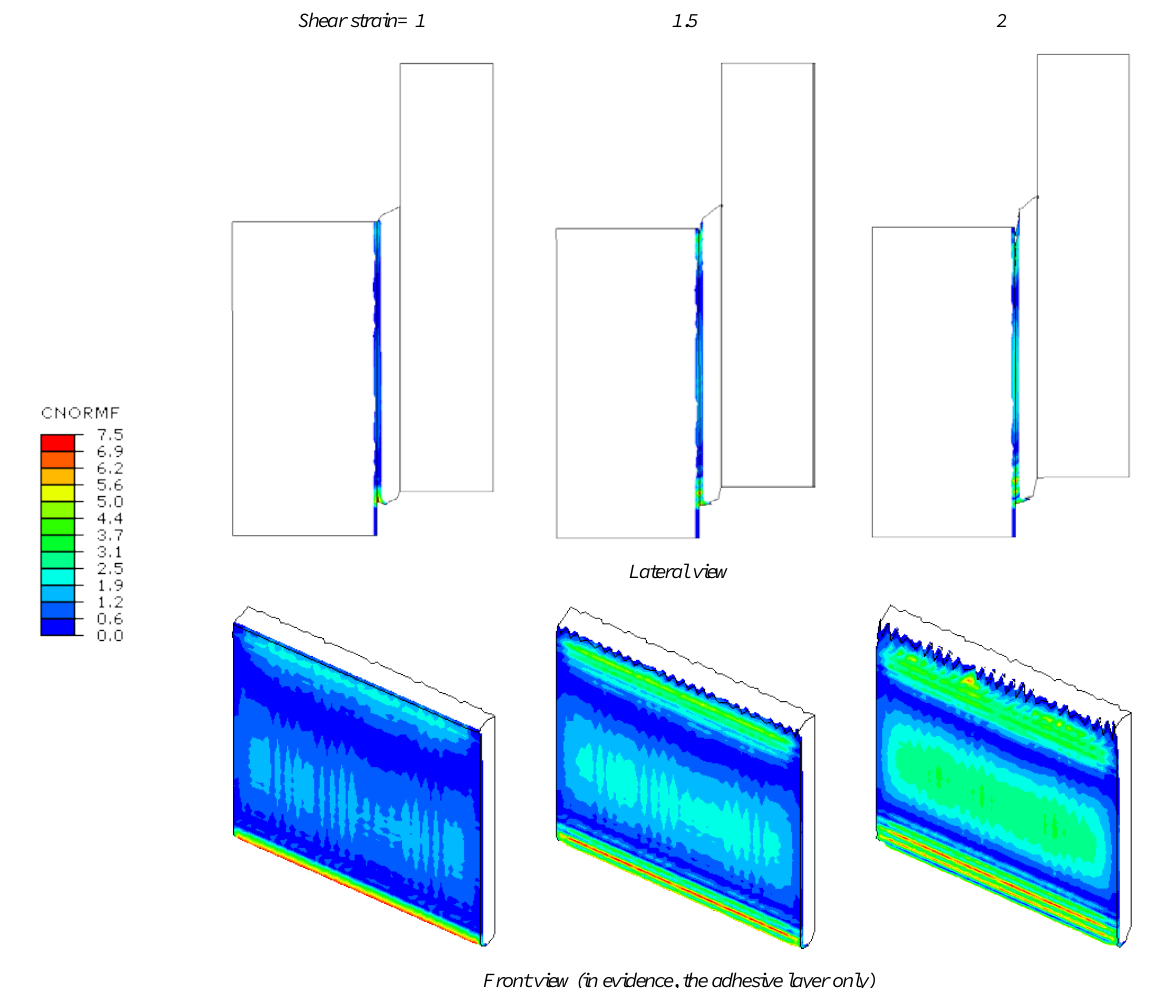
Fig. 9 Evolution of normal forces at the glass-to-adhesive interface, in the M0C model (ABAQUS, 1/4 specimen), with δ f =1.5mm and t 0 =8MPa the CZM input. In evidence, the adhesive